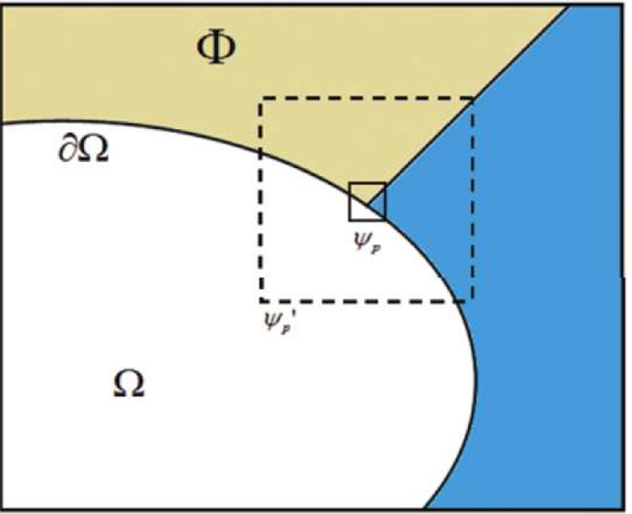
Fig 1. Φ is the source region/image, Ω is the target region and @ Ω represents the boundary between the source region and the target region. ψ p is the patch that will be filled, c 0 p stands for a bigger patch having the same center p with ψ p